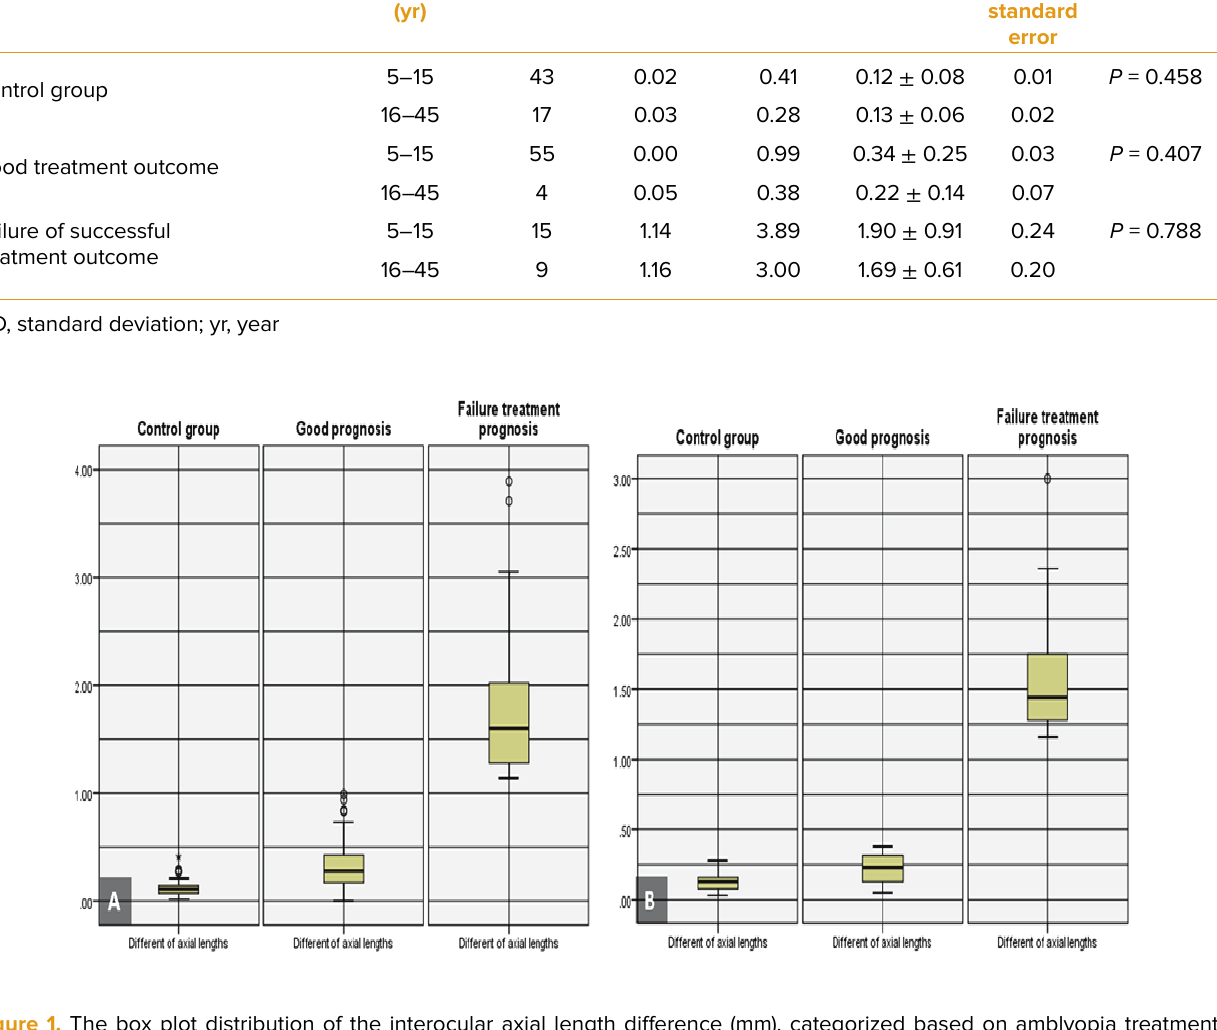
Figure 1. The box plot distribution of the interocular axial length difference (mm), categorized based on amblyopia treatment outcomes in the children (A) and adults (B)